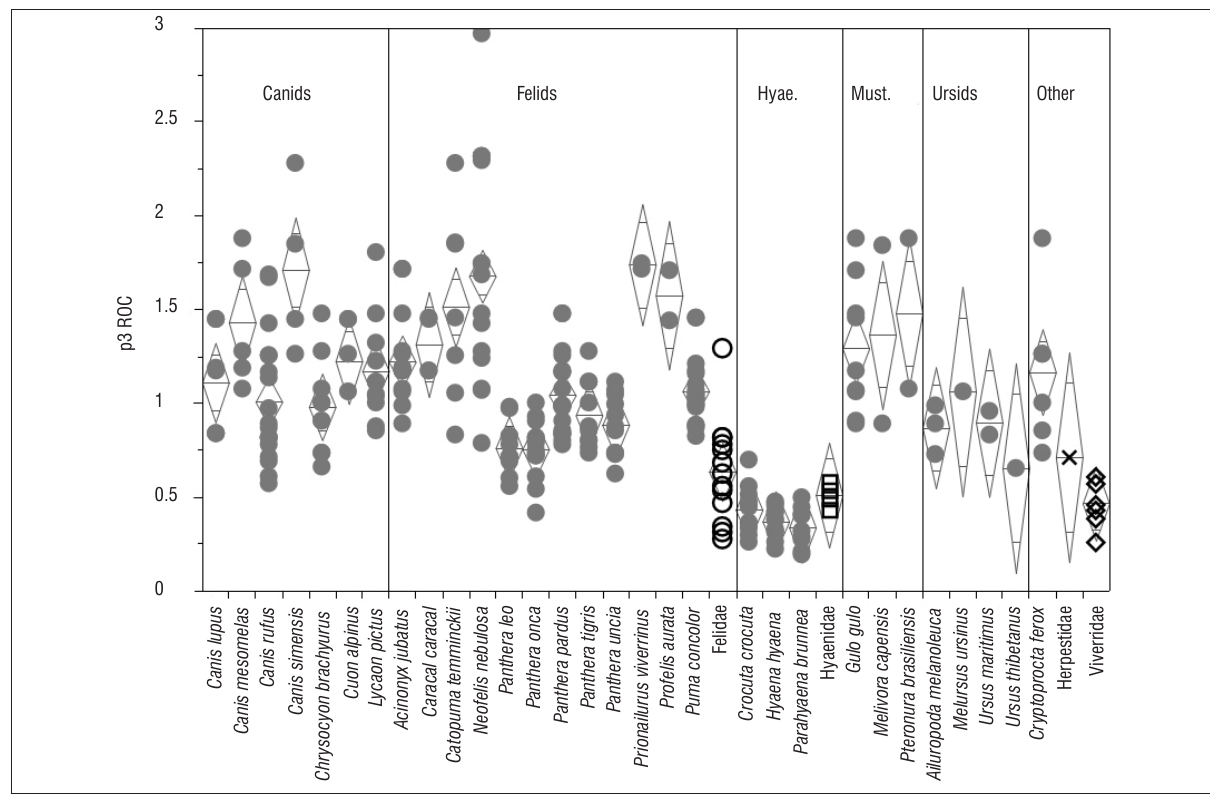
Extant taxa are represented by solid grey circles, Langebaanweg (LBW) felids by open circles, LBW hyaenids by open squares, LBW mustelids by open triangles, the single analysed LBW herpestid by an ‘x’ sign, and LBW viverrids by open diamonds. Each dotted diamond represents the mean and 95% confidence interval vertical span; the horizontal lines are the mean and ‘overlap marks’ that indicate statistical separation. Figure 4: Radii-of-curvature (ROC) score of the third (p3) lower premolars by species and/or